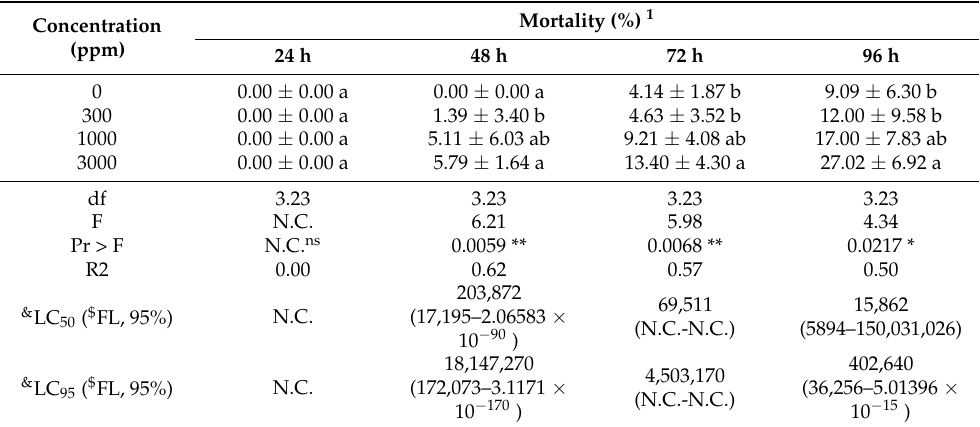
Table 5. Mortality ( ± SD) of tomato psyllid Bactericera cockerelli , at different concentrations of ZnO NPs on tomato in the